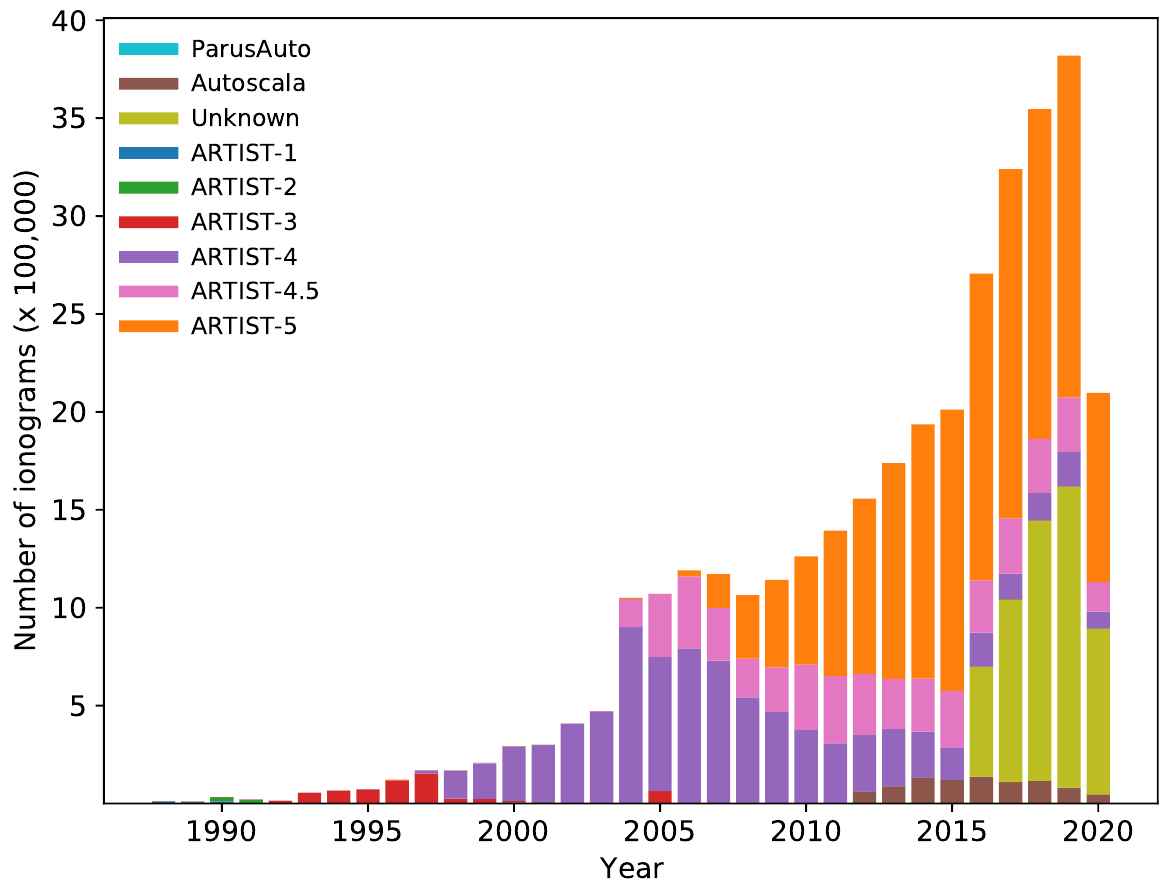
Figure 3. The number of ionograms automatically scaled over time separated by autoscaling software and